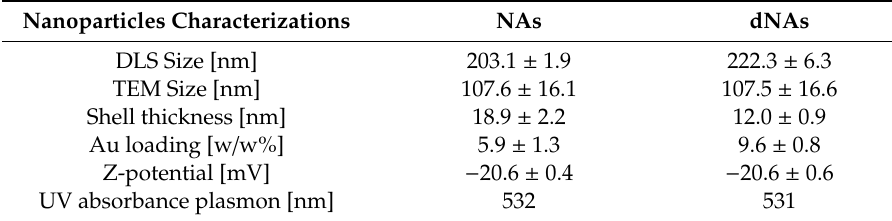
Table 1. Comparison between NAs and